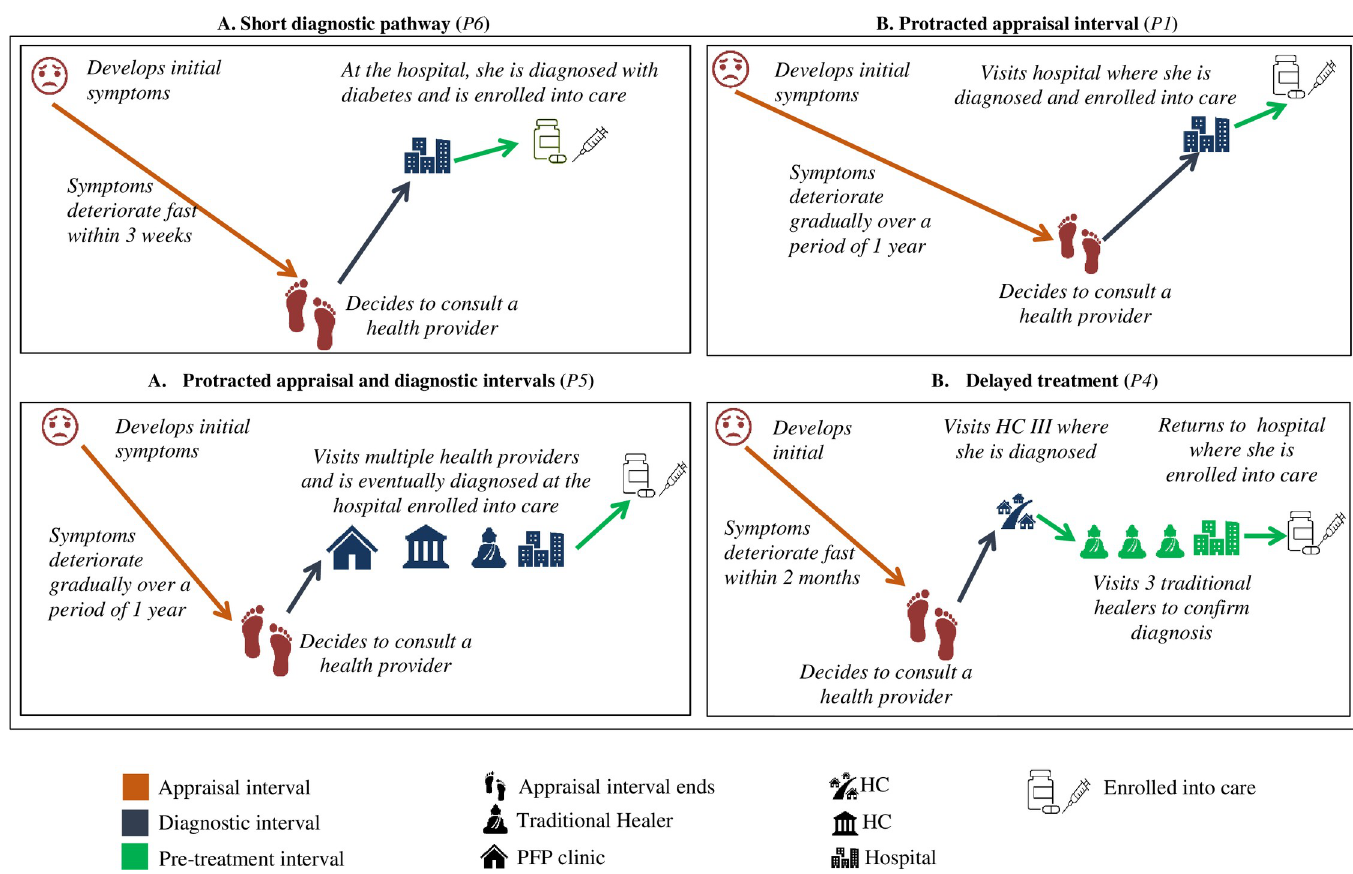
Fig 2. Schematic representation of the four diagnostic pathway typologies using representative patient cases (in brackets). The pathways are not drawn to scale.